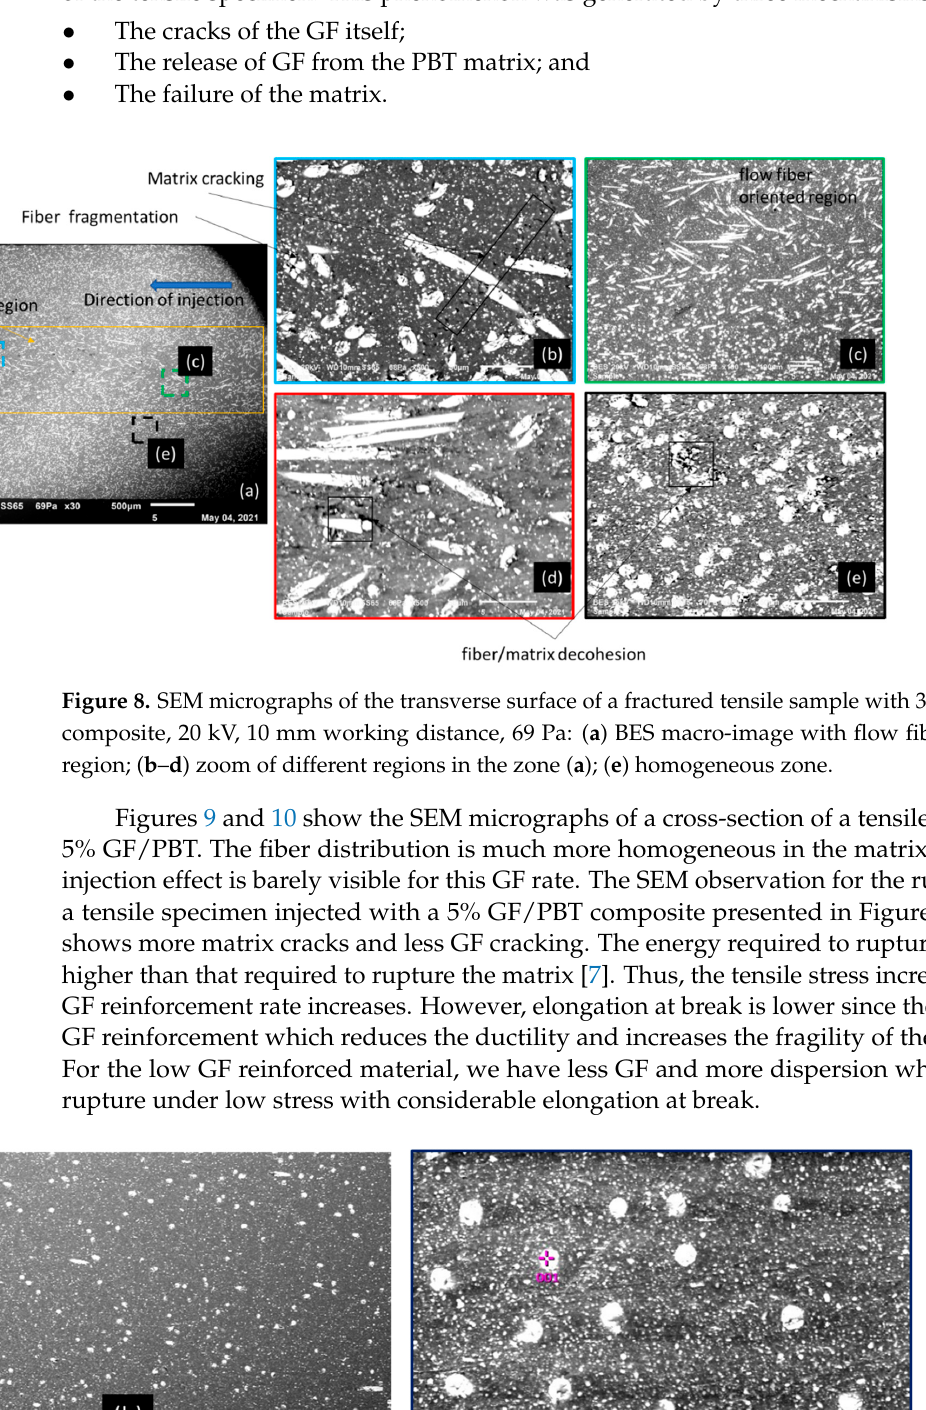
Figure 10. SEM micrographs of the transverse surface of a fractured tensile test sample with 5% GF/PBT composite, 20 kV, 10 mm working distance, 70 Pa: ( a ) BES macro-image; ( b , c ) zoom of dif- ferent regions in the zone ( a ). Figure 11 shows SEM micrographs of a cross-section of a tensile sample of pure resin PBT.